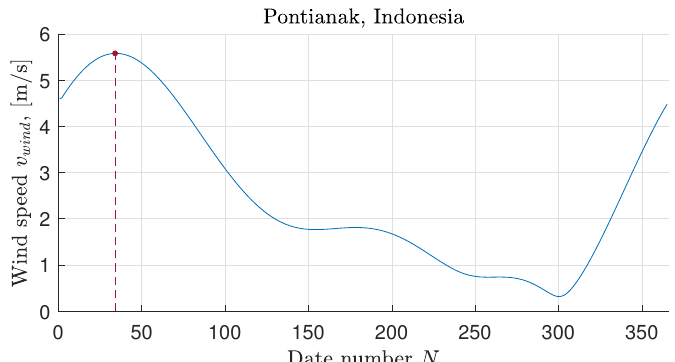
Figure 5. Airstream speed over the year at a 20 km altitude above Pontianak, Indonesia (0 ◦ 1 (cid:48) 14 (cid:48)(cid:48) S, 109 ◦ 20 (cid:48) 29 (cid:48)(cid:48) E). Values measured at